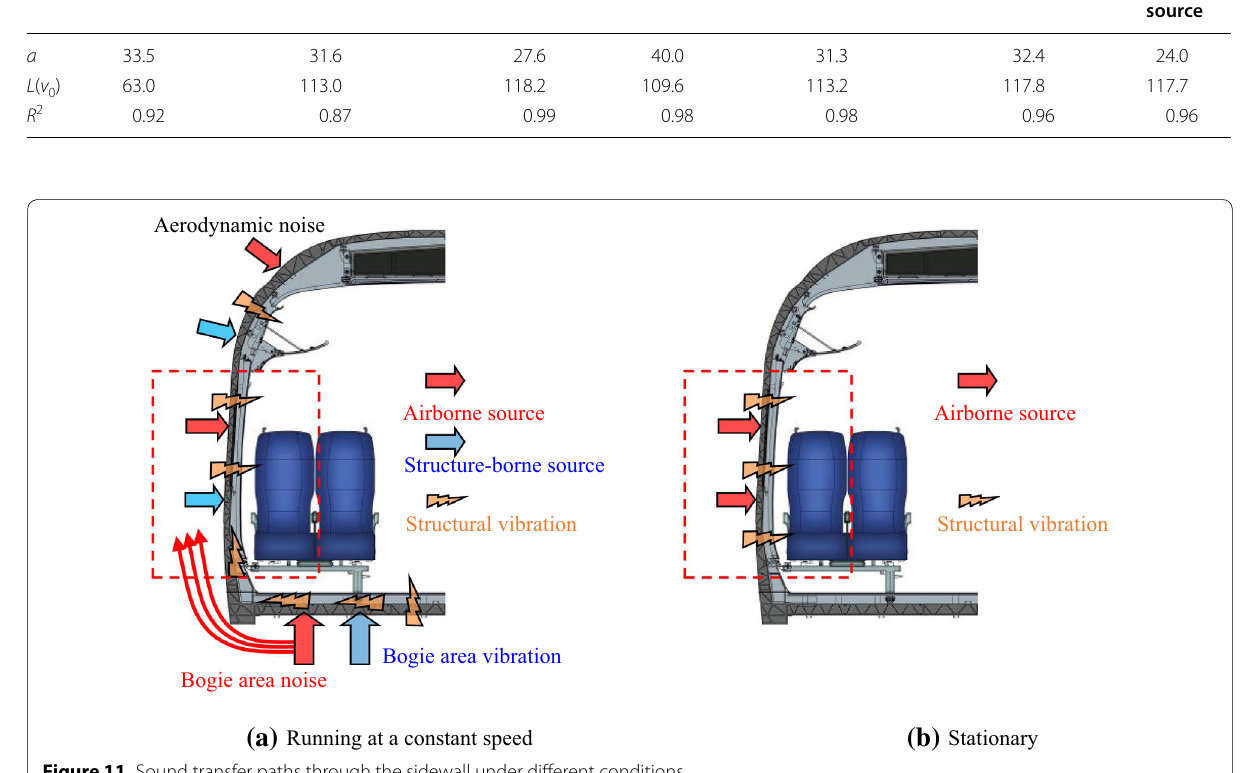
Figure 11 Sound transfer paths through the sidewall under different